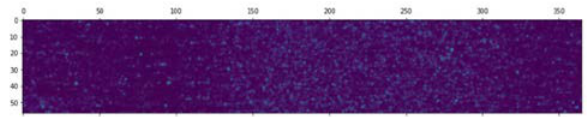
Figure 4. Heat Map of a typical yearly rainfall data